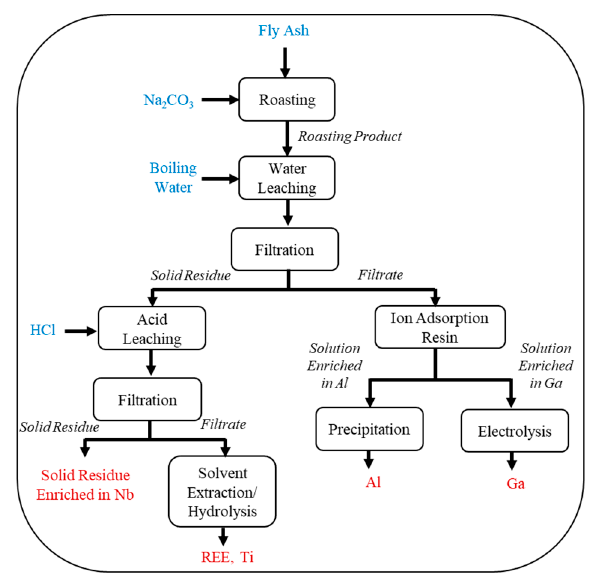
Figure 9. A flowsheet for recovering REEs, Ga, Nb, and Al from a fly ash using alkali roasting [112].